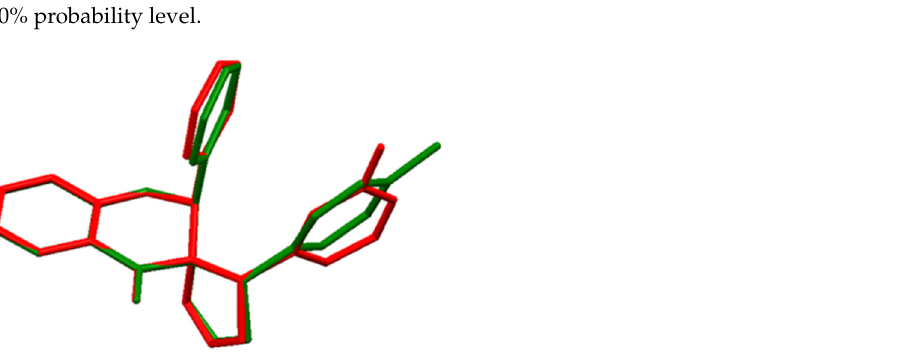
Figure 3. Molecular overlays of two derivatives: compound I —red, compound II —green. Hydrogen bonds are omitted for clarity.